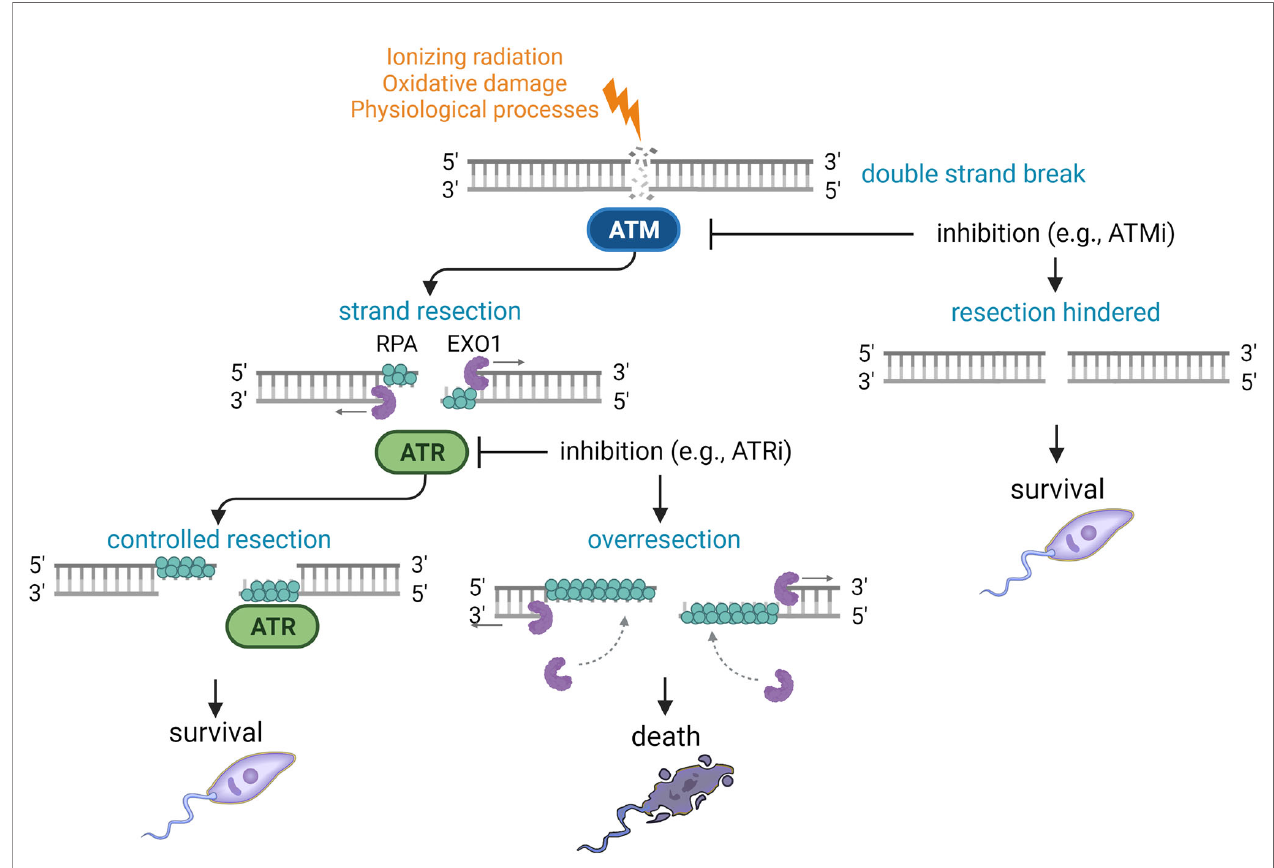
FIGURE 5 | Theoretical model for the DNA damage and response in Leishmania . Schematic model to hypothesize the mechanisms controlling the DNA damage and repair in Leishmania , formulated according to the fi ndings of the present work. Ionizing radiation, oxidative damage or endogenous physiological processes can cause many types of DNA damage (e.g. double strand breaks). In the damaged site, the putative homologue protein LmjATM (in blue) may be activated and stimulate the end resection by the enzyme LmjEXO1 (in purple). In other eukaryotes, many DNA damage responders, including the MRN-Sae2 complex, PCNA and RPA (in cyan), can activate EXO1. The extended 3 ’ ssDNA is covered by RPA, generating a signal for the recruitment of the putative homologue protein LmjATR (in green). As seen in other eukaryotes, LmjATR can modulate the end resection. After repairing the damage, the cell cycle can proceed and the parasite can recover and multiply. When overexpressed, or when the LmjATR modulation is de fi cient (e.g., by inhibition with ATRi), LmjEXO1 can continue the end resection, generation too long 3 ’ ssDNA ends, which can lead to generalized genomic instability and, consequently, to the parasite death. The parasites can possibly escape the deleterious effects of LmjEXO1 overexpression with the inhibition of ATM (e.g.: using ATMi), preventing the end resection. In this case, the parasites could use alternative pathways to repair the DNA damage. Lightning: DNA damage; grey arrow: end resection